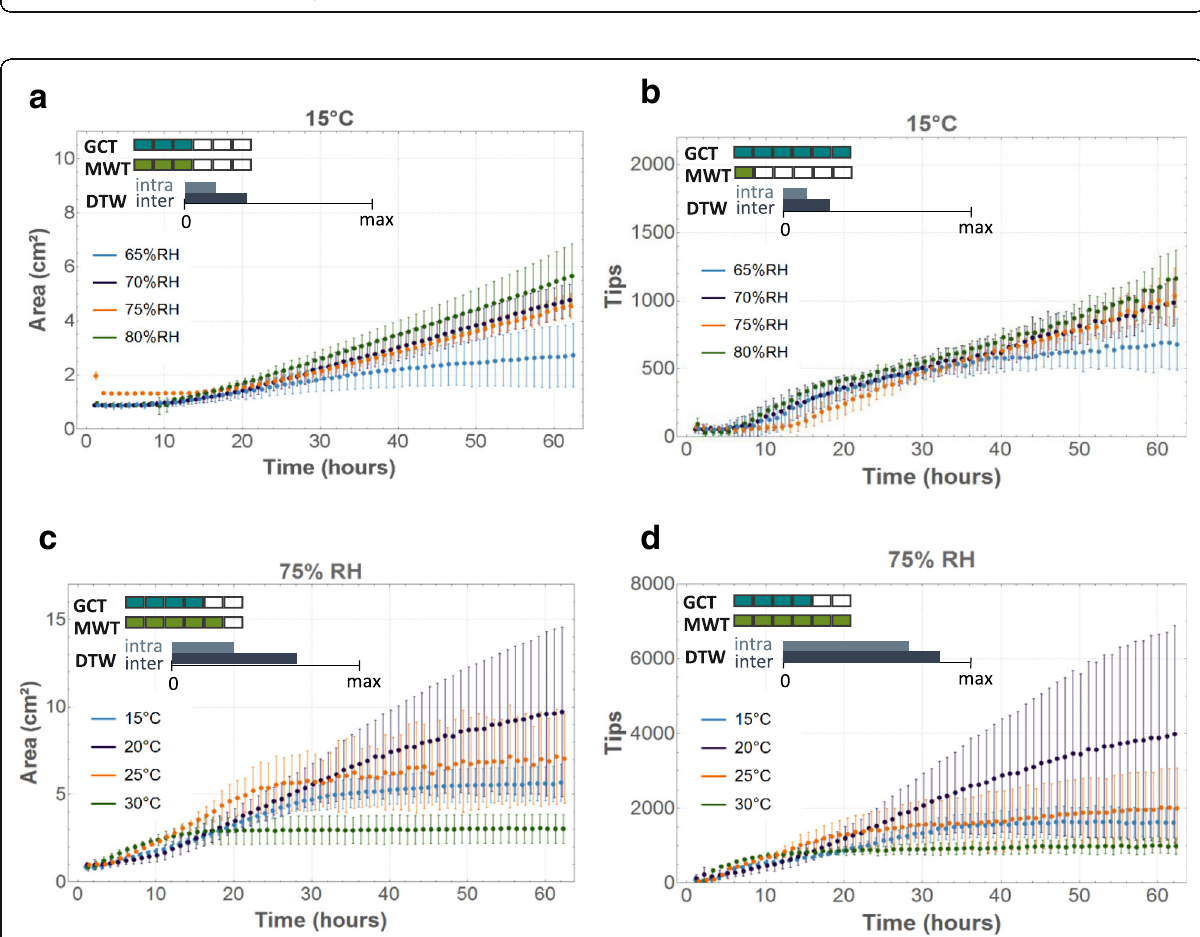
Fig. 7 Evolution of mycelial area (cm 2 ) and the number of tips over time for C. puteana ( a , b ) and R. solani ( c , d ). The dots represent the mean values over four replicates, with the bars indicating the standard deviation. For each graph, six pairwise GCT and MWT were performed between the four conditions represented in that graph. The two colour scales indicate for how many of those pairwise comparisons a difference was found according to GCT (blue) and MWT (green). The third scale represents the difference between the average DTW distance between the four conditions represented in the graph and a reference ground value, being the average DTW distance over the replicates in that graph. The bigger the bar, the more difference there is between conditions. When the DTW scale is negligibly small, the difference between conditions is insignificant compared to the reference DTW difference between